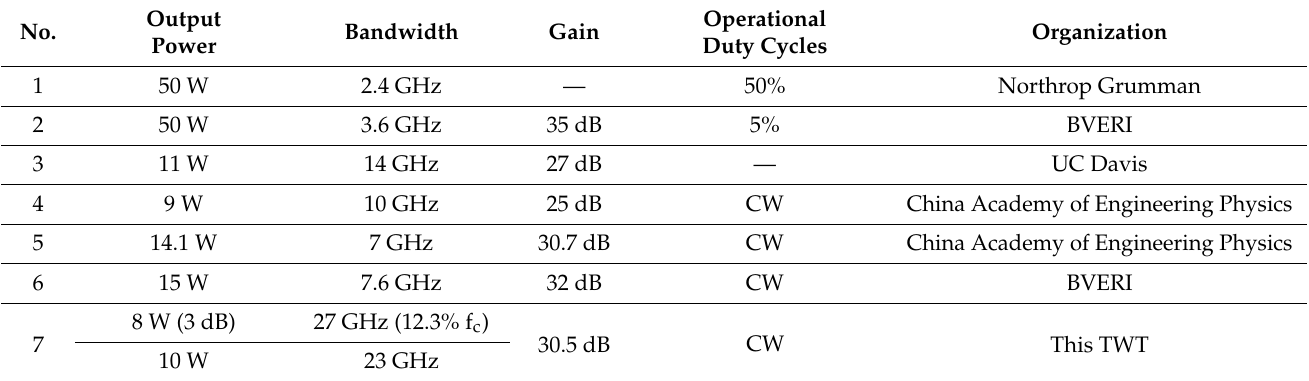
Table 1. Some G-band TWTs performances in recent